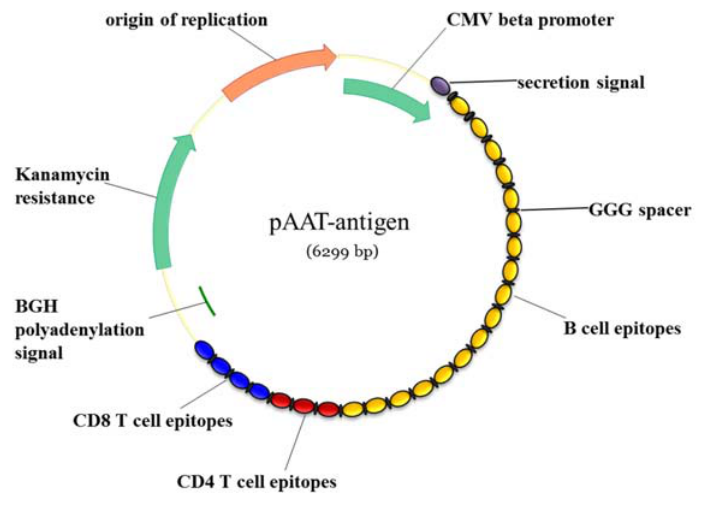
Figure 2. Map of the proposed pDNA vaccine construct.